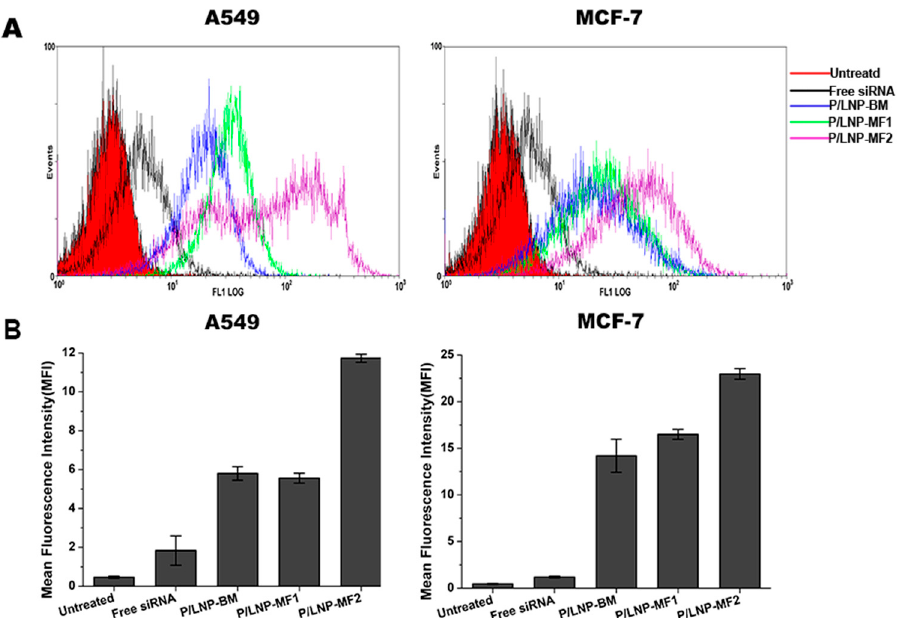
Figure 4. Uptake of FAM-siRNA loaded P/LNPs in A549 cells and MCF-7 cells by flow cytometry. Cells were incubated with different P/LNPs at 37 °C for 4 h, and then analyzed by flow cytometry. ( A ) Fluorescence signals intensity graphs; ( B ) the mean fluorescence intensities of A549 cells and MCF-7 cells. The data are displayed as mean ± SD ( n = 3).